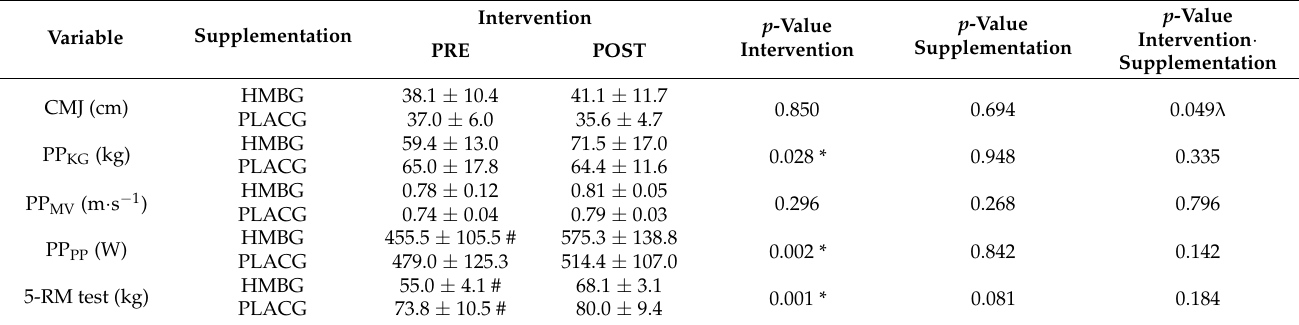
Table 2. Performance variables in the CMJ, BS incremental test and 5-RM